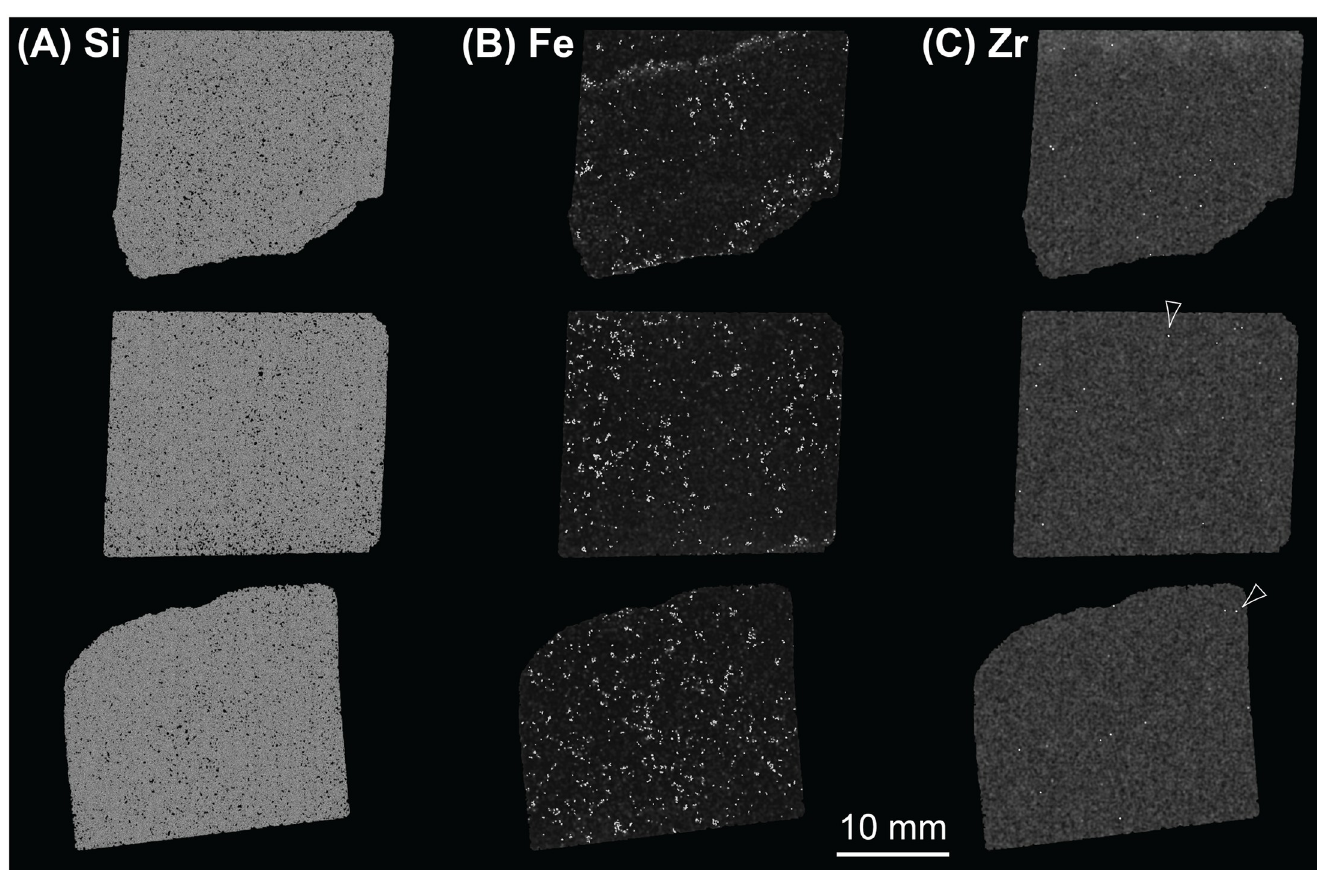
Fig 17. Composite showing μ XRF elemental maps of thin sections SH1B (bottom row), SH2B (middle row) and SH3B (top row) from the Phillips’ Core (from Stone 58 at Stonehenge) for (A) Si, (B) Fe and (C) Zr. Note that Zr is present at much lower concentrations than Si and Fe so some background noise is present in panel C—example spots of higher Zr intensity are